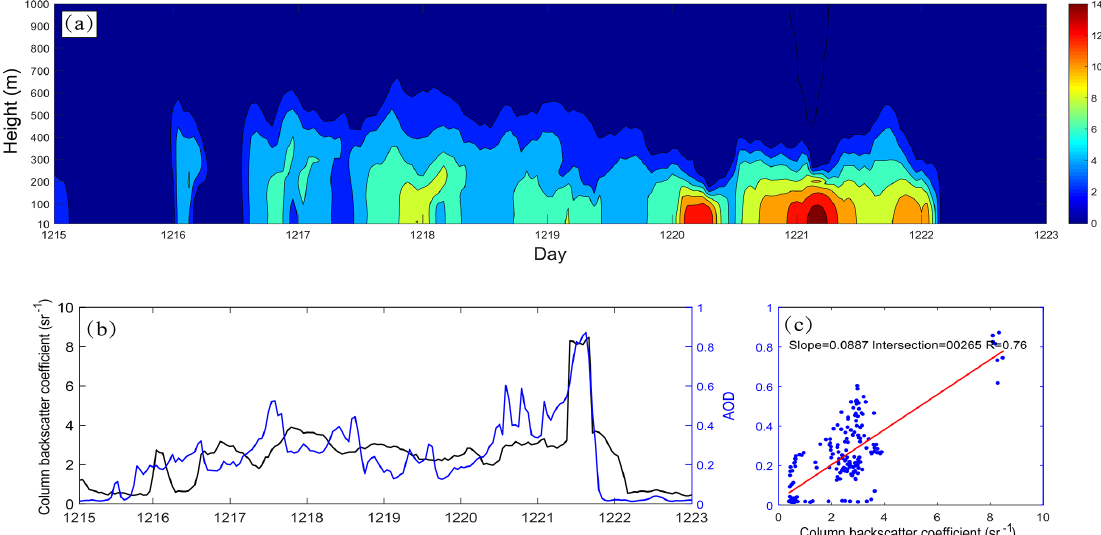
Figure 2. (a) Hourly backscattering coefficient (shading; Mmsr − 1 ) observed by single-lens ceilometers (39.97 ◦ N, 116.37 ◦ E) from 15 to 23 December; (b) hourly column backscatter coefficient (black line; sr − 1 ) and AOD used in modeling for Beijing (blue line); and (c) scatter diagram of hourly column backscatter coefficient and AOD (blue dots) and their correlations (red line). Table 2. Model evaluation (RMSE and BIAS) for the four tests. Test 1 Test 2 Test 3